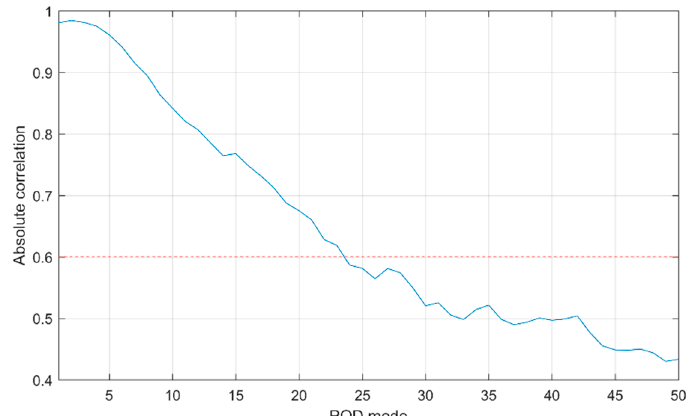
Figure 12. Maximum absolute correlation for each POD spatial mode (curtailed at mode 50). Smoothed data is used to produce trend. A cut-off at 60% correlation is indicated.